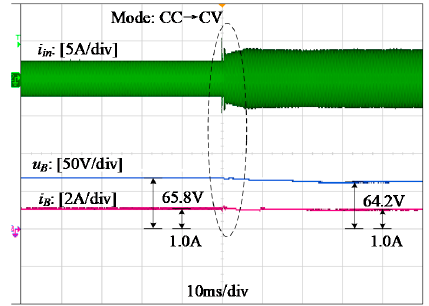
Figure 17. Transient waveforms of i in , u B and i B from CC mode to CV mode